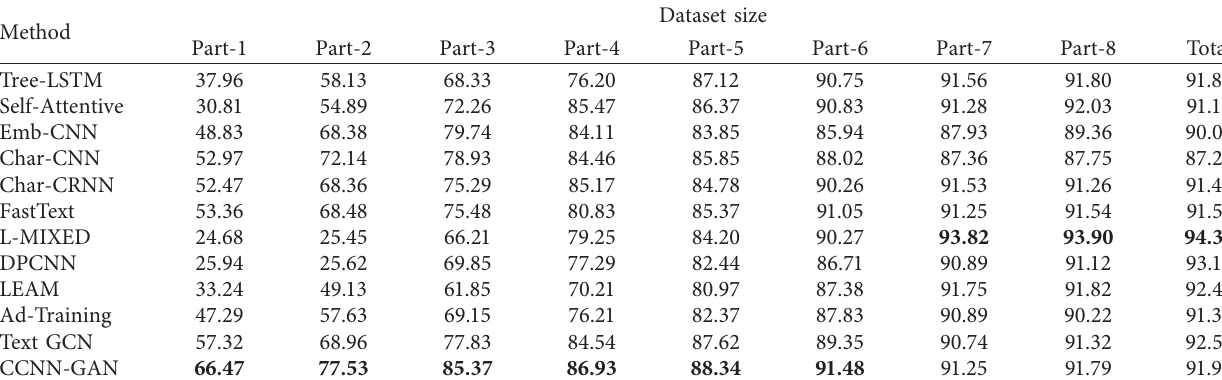
Table 4: Test performance on the AG-news classification task.